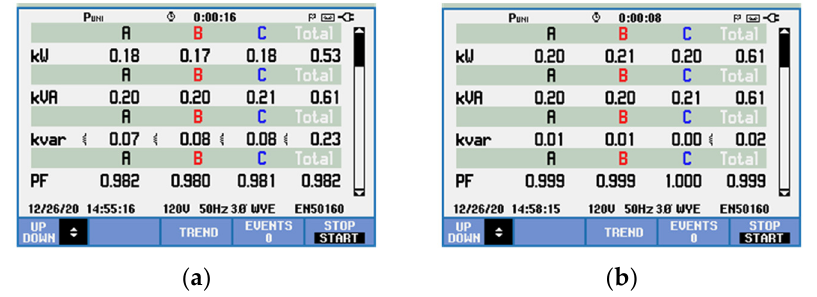
Figure 17. Analysis results of power and electric energy: ( a ) Traditional method; ( b ) proposed method.